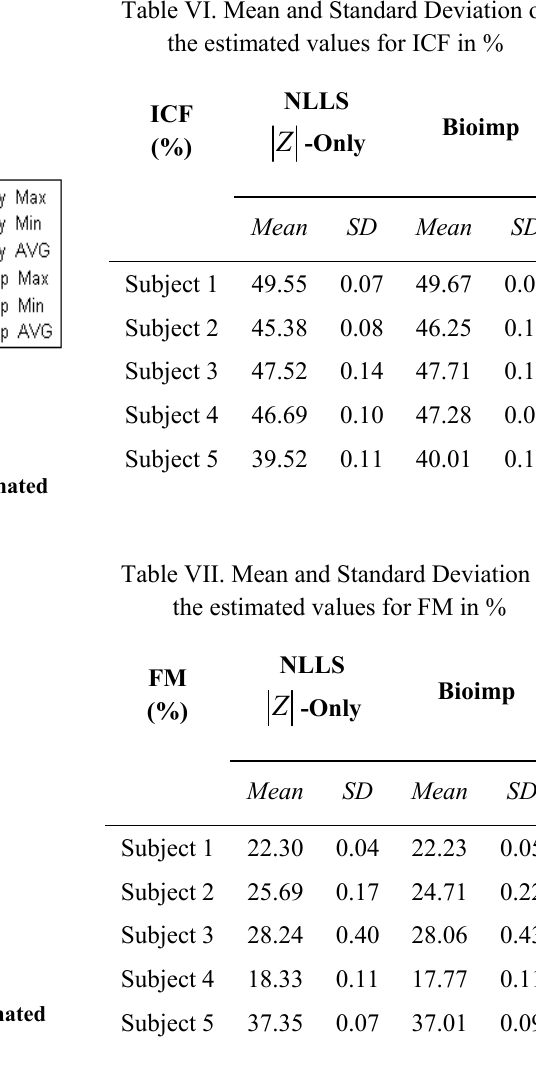
Table VIII. Differences obtained on the estimation of the BCA parameters Δ (%) / (l)